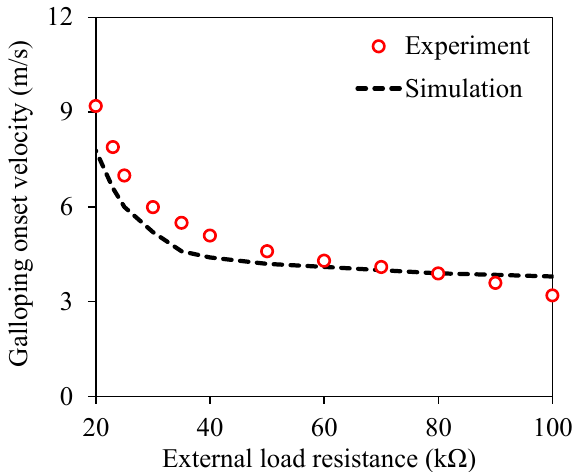
Figure 14. Variation of the galloping onset wind velocity with external load resistances.